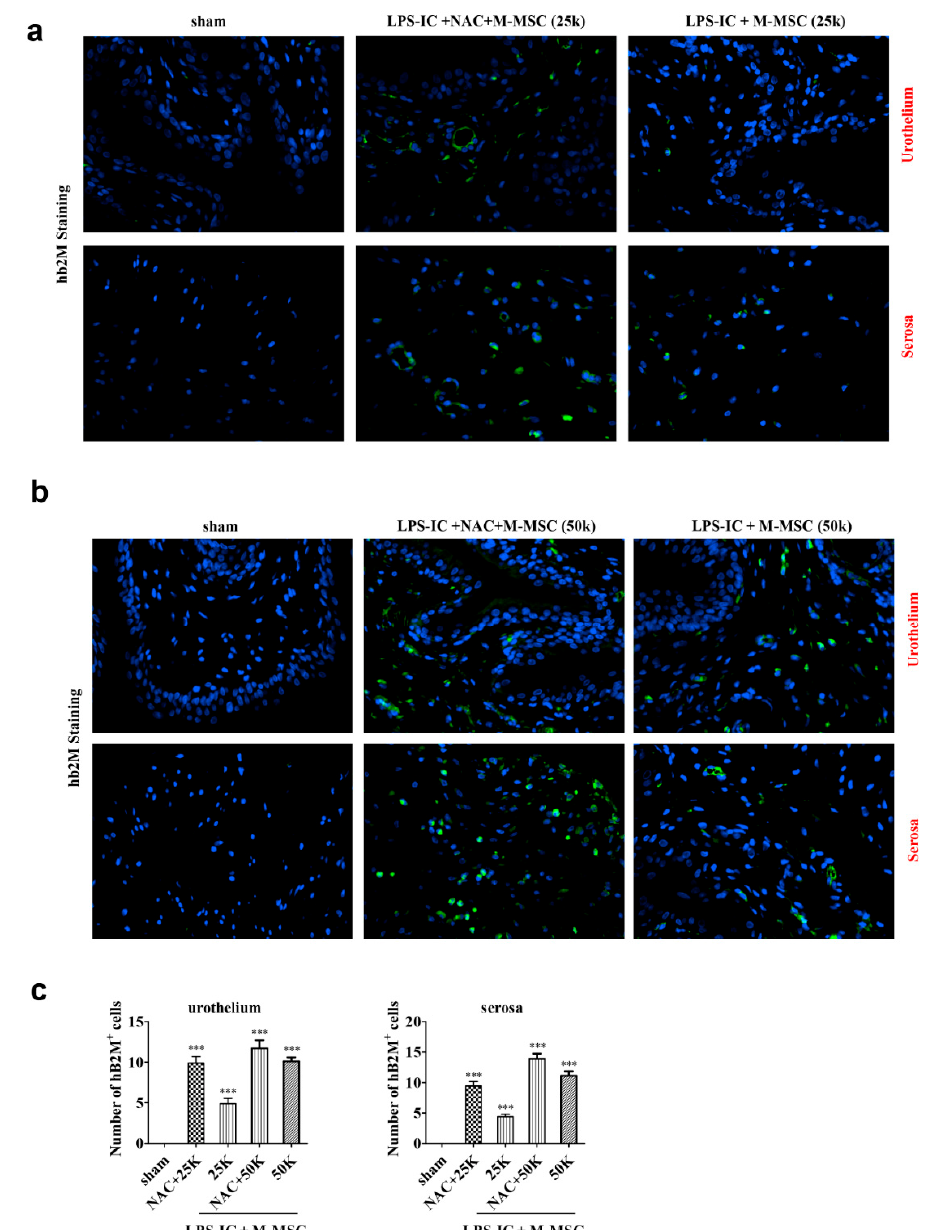
Figure 6. Human antigens in transplanted M-MSCs. ( a ) Representative immunofluorescence micrographs of bladder sections of LPS-IC + 25K M-MSC rats stained for hB2M (green) structures (magnification × 1000, scale bar = 10 µ m). ( b ) Representative immunofluorescence micrographs of bladder sections of LPS-IC + 50K M-MSC rats stained for hB2M (green) structures (magnification × 1000, scale bar = 10 µ m). Nuclei were stained with DAPI (blue). ( c ) Number of transplanted M-MSCs (hB2M positive cells) in urothelium and serosa. DAPI: 4’,6-diamidino-2-phenylindole